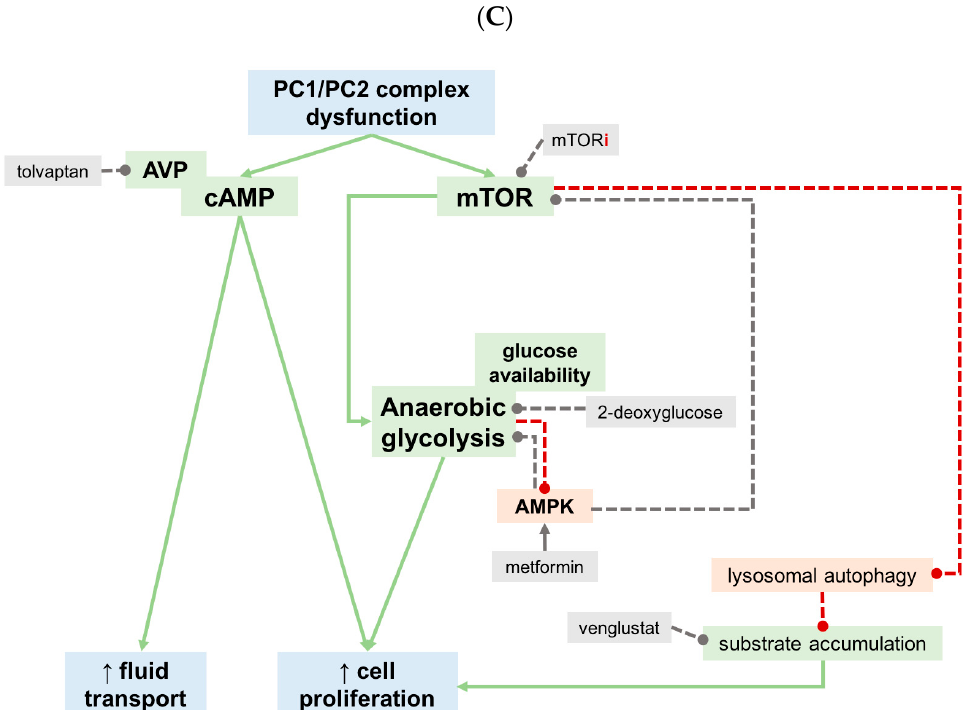
Figure A1. Current understanding of the molecular pathways involved in the pathogenesis of ADPKD and impact of dietary manipulation and of drugs currently in use or undergoing clinical trials for ADPKD. ( A ) Molecular pathways. Dysfunction of the polycystin-1 / polycystin 2 (PC1 / PC2) complex in ADPKD increases intracellular cyclic adenosine monophosphate (cAMP), which increases fluid transport into the cyst, and also increases cell proliferation which allows the cyst to increase in size. Arginine-vasopressin (AVP) further increases intracellular cAMP. PC1 / PC2 complex dysfunction also stimulates the mTOR pathway that contributes to activate anaerobic glycolysis, and this favors cell proliferation and inhibits AMPK, but renders cells dependent on glucose availability. Increased mTOR activity may also disrupt the autophagy-lysosomal pathway and may increase the accumulation of certain substrates. ( B ) Impact of diverse dietary manipulation maneuvers over molecular pathways, as evidenced by preclinical cell and animal models of ADPKD. A low osmolal diet and water intake inhibit AVP, thus decreasing cAMP. A high caffeine intake may increase cAMP, but there is little evidence of clinical relevance at usual daily caffeine doses. Ketogenic diets, time-restricted feeding, and caloric restriction decrease glucose availability, inhibit the mTOR pathway, stimulates AMPK, and result in ketogenesis that decreases cell proliferation. On the other hand, time-restricted feeding and caloric restriction stimulate lysosomal degradation and autophagy. ( C ) Current therapy for ADPKD (tolvaptan) or drugs undergoing clinical trials for ADPKD. Clinical experience with venglustat, a glucosylceramide synthase inhibitor (NCT03523728) or metformin (NCT03764605, NCT02656017) has not yet been published. Blue background: structural alterations. Green background: activated molecular pathways. Red background: decreased molecular pathways. Continuous arrows: routes that activate. Red dashed arrows: pathways that inhibit. Grey discontinuous arrows: pathways that could inhibit but are not activated in ADPKD.